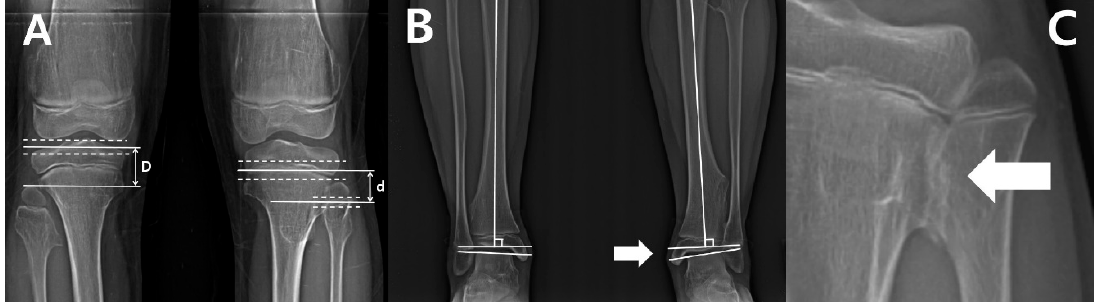
Figure 1. ( A ) The distance of proximal epiphyses (D) and physes (d) between tibia and fibula. The distance of proximal epiphyses was defined as the gap between the parallel line past the apex of the proximal fibula and the parallel line past the center of the distance between the line across the apex of the tibial spine and the most bottom of the condyle. The distances of proximal physes was defined as the gap between the parallel line passing through the midpoint of the distance between the line across the top of physis; the line crossing the bottom of physis was set as the reference line. ( B ) The measurement of the ankle joint. The tibiotalar angle was defined as the extension line of the tibial anatomical axis and a line perpendicular to the extension line that touches the dome of the talus. The left lower extremity indicated by the white arrow demonstrates a decreased distal tibiofibular distance compared to the right side, and a prominent ankle valgus deformity is also observed. ( C ) The tibiofibular synostosis. The white arrow indicates a definite bridge of an exostosis lesion connecting the proximal fibula and tibia without the overlapping cortex.